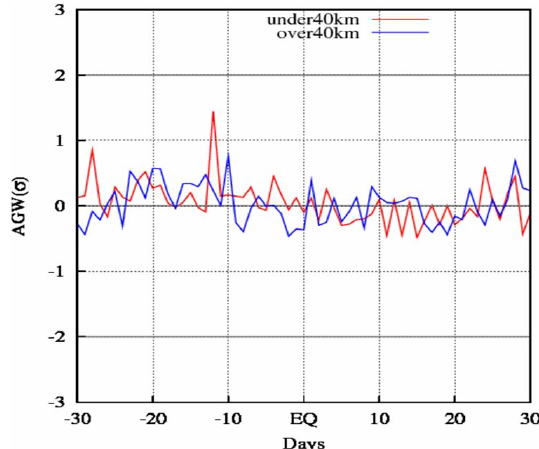
Fig. 5. The superimposed epoch analysis of the AGW modulation in subionospheric VLF/LF data (Kasahara et al., 2010). The result is based on the long-enough period of nine years by using the different propagation paths in and around Japan. EQ magnitude is taken to be greater than 6. The red line refers to shallow (depth > 40km) EQs, while the blue one refers to deep (depth > 40km) EQs. The abscissa indicates the day before an EQ (minus) and the day after the EQ (plus). EQ days is given as zero. The ordinate is the normalized AGW modulation